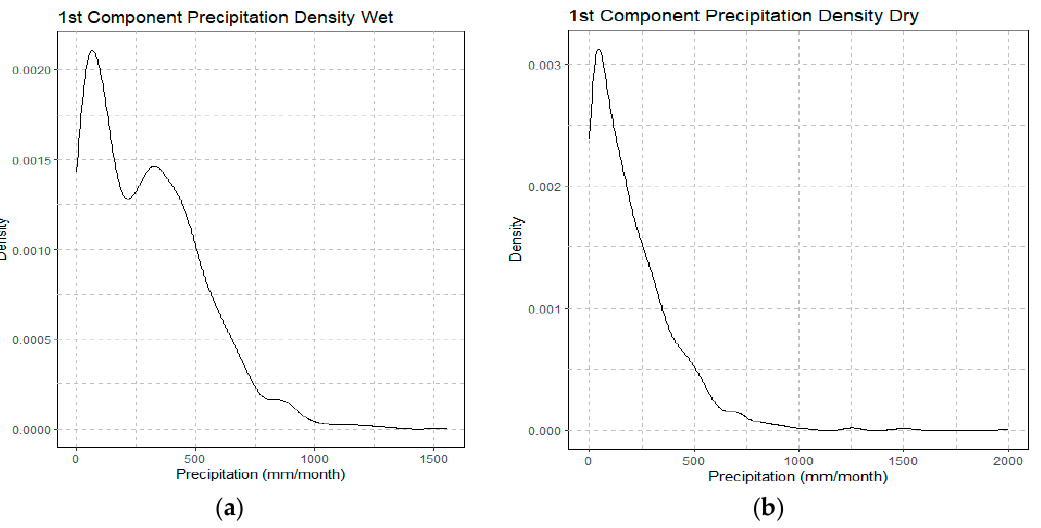
Figure 8. Kernel pdfs with n = 1000 points, results for 1st component in the ( a ) wet season and ( b ) dry season of monthly average rainfall values (2010–2019). Source: author’s processing. Table 6. Summary statistics for dry and wet seasons in the 1st component. Source: author’s